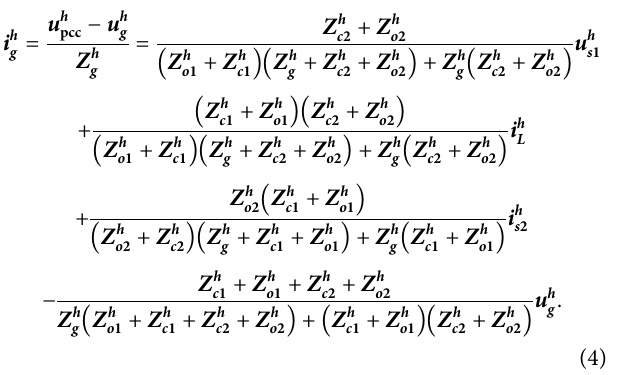
FIGURE 7 | Flow chart of the distribution network